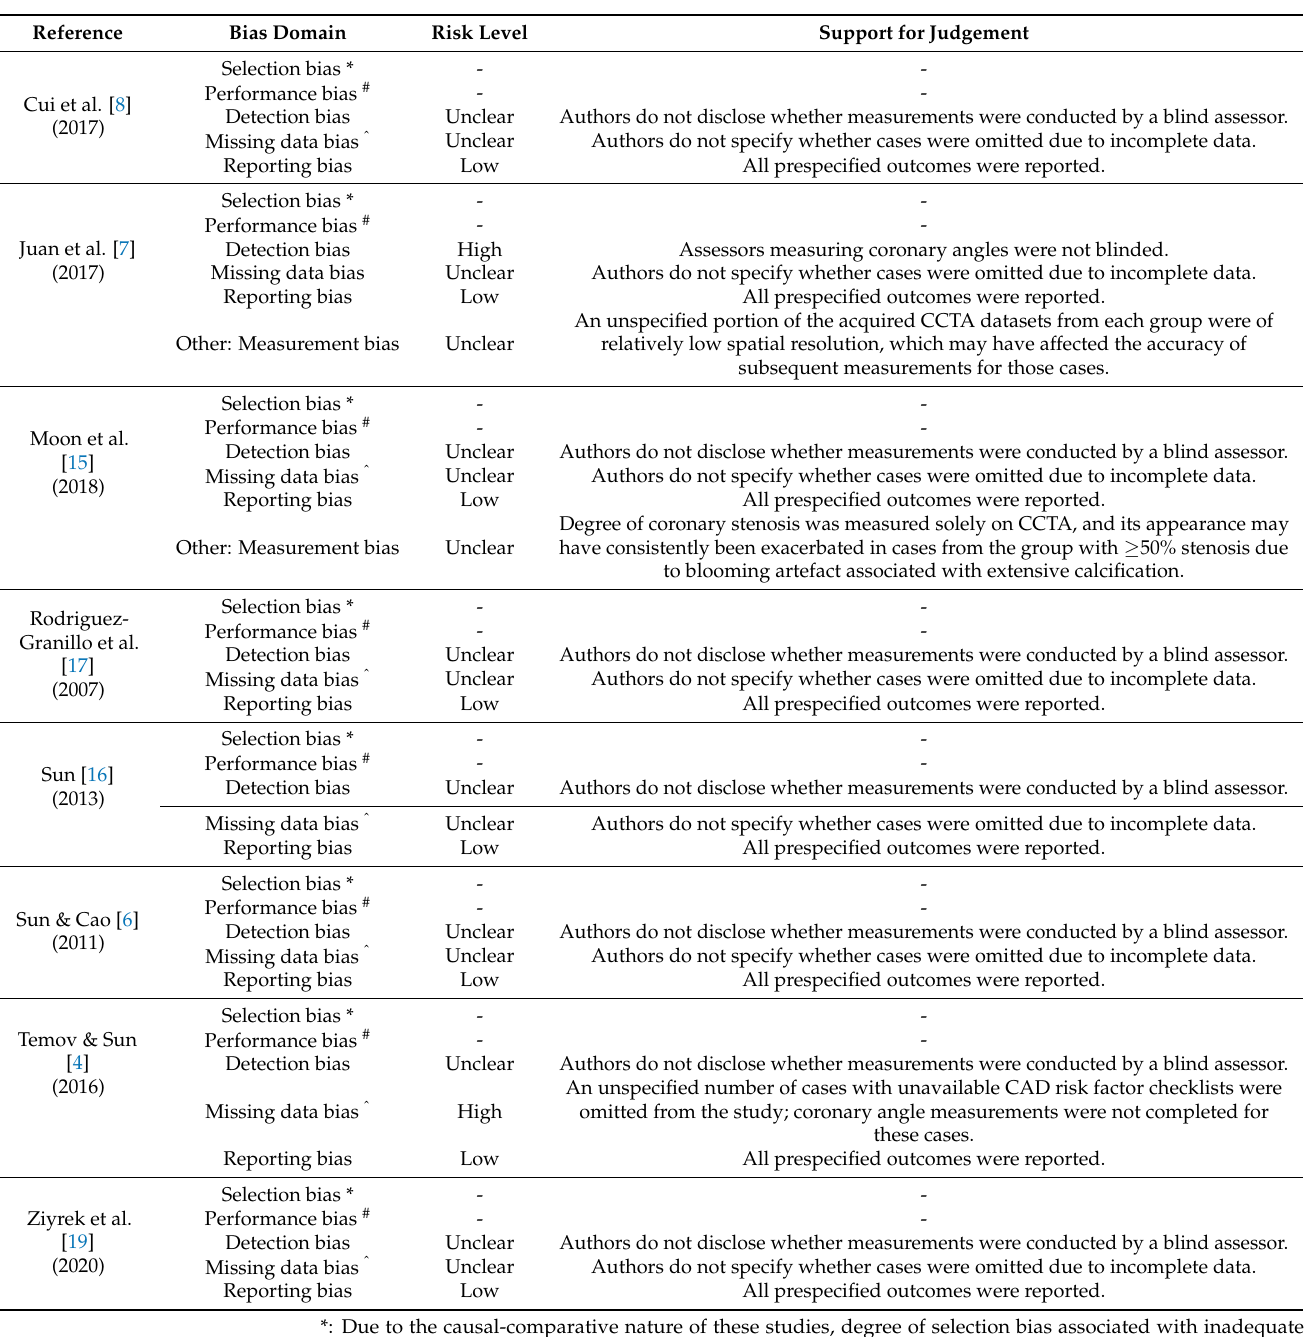
Table 3. Risk of bias assessment among the studies that were